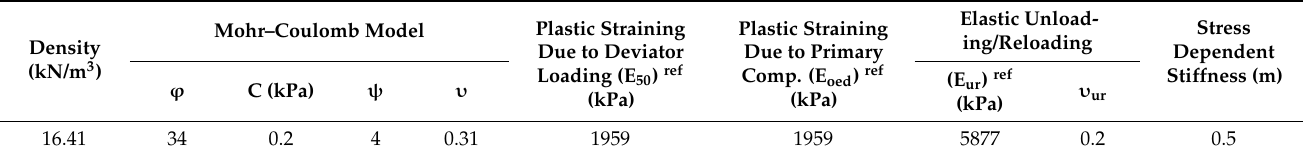
Table 3. Soil parameters of sand used in material model.